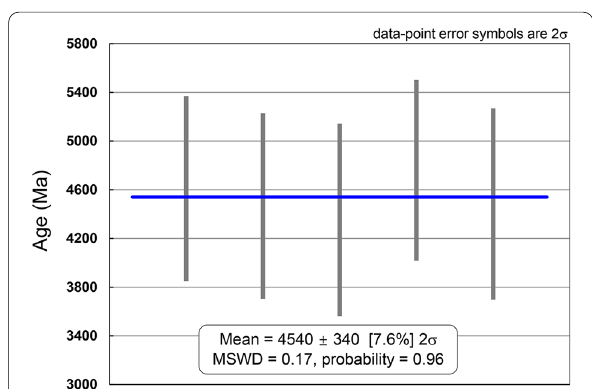
Fig. 3 Weighted mean U–Th–Pb EPMA chemical ages of zirconolite in NWA 4485